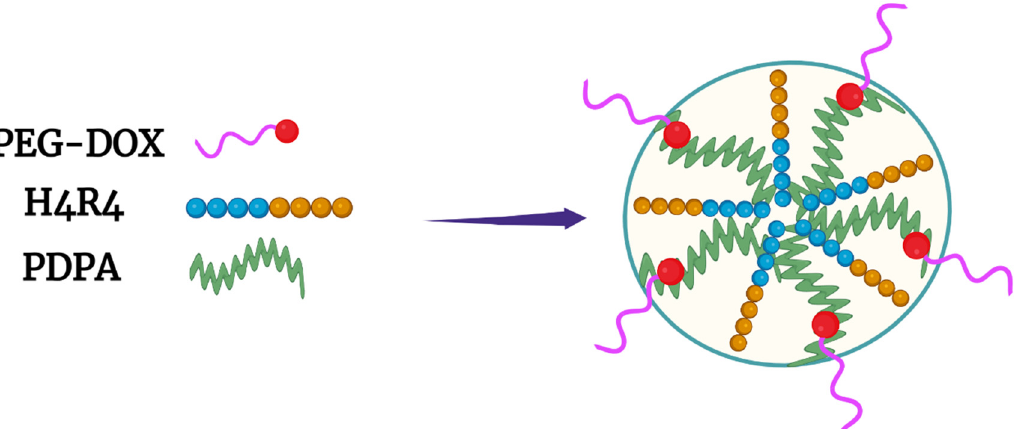
Figure 4. Micelle formed with PEG-Dox conjugate and the hydrophobic PDPA polymer. The H4R4 peptide enhanced endosomal lysis, increasing Dox release into the cytosol.